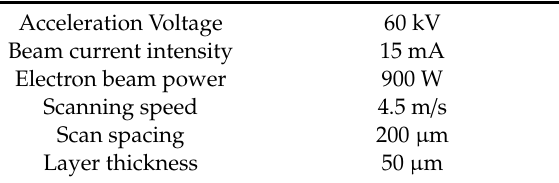
Table 1. Parameters of the electron beam powder bed fusion (EB-PBF)